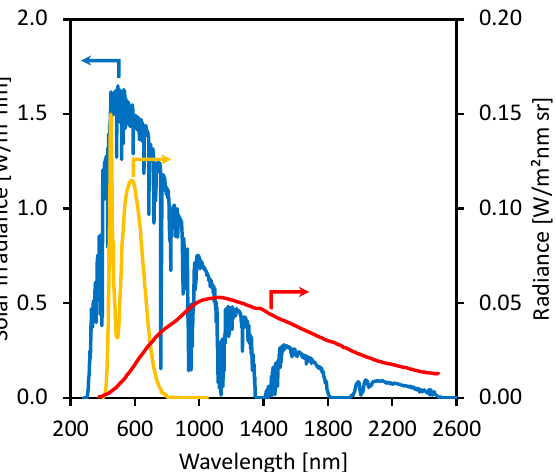
Figure 3. ASTMG 173 AM1.5 solar emission spectrum (blue), and common incandescent light bulb (red) and natural white 100 W LED lamp (yellow) spectra [39]. Note the different ordinate scales.